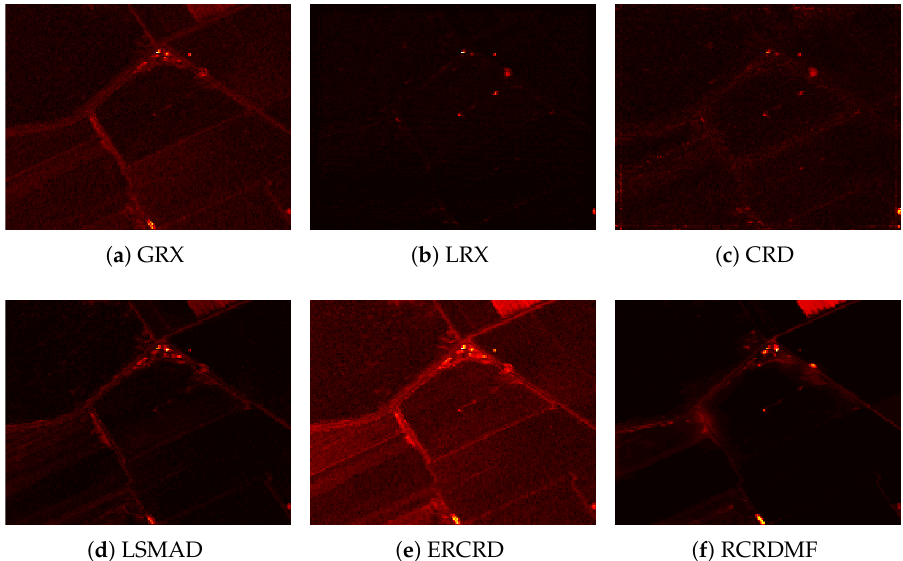
Figure 15. Color detection maps obtained by different algorithms for the Salinas dataset. ( a ) GRX,